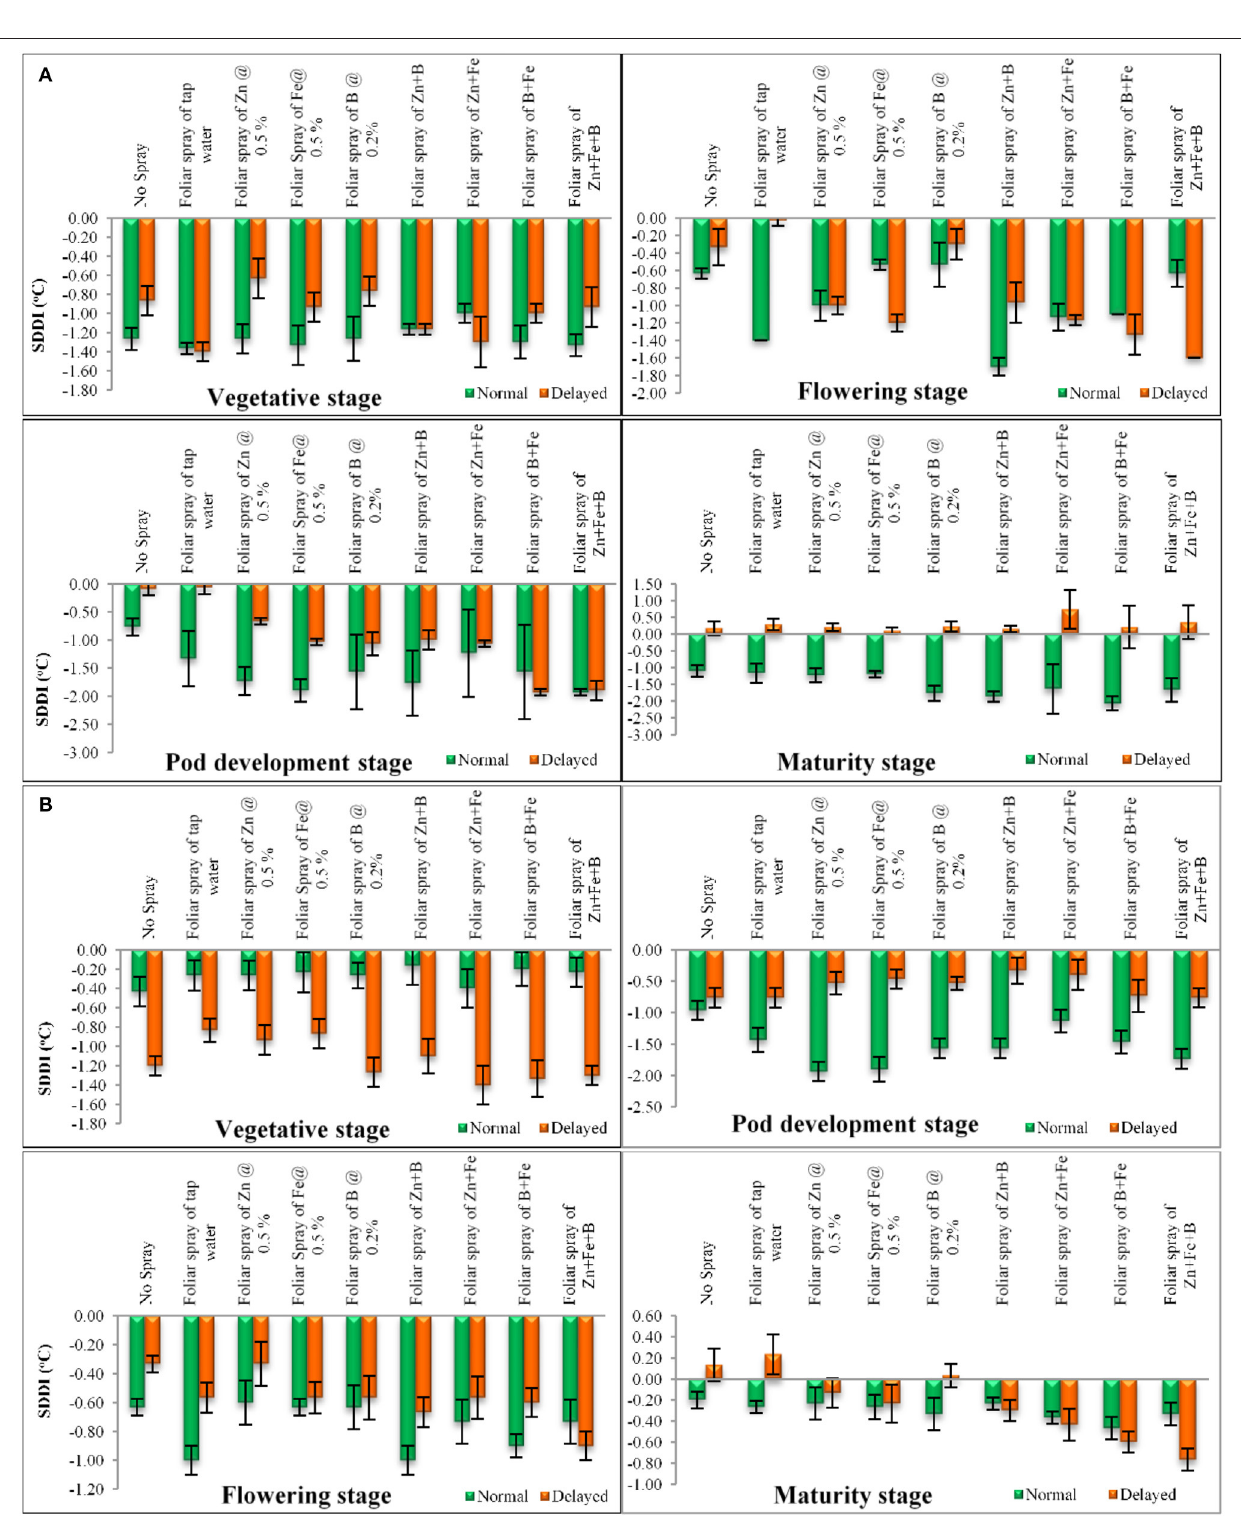
Frontiers in Plant Science |